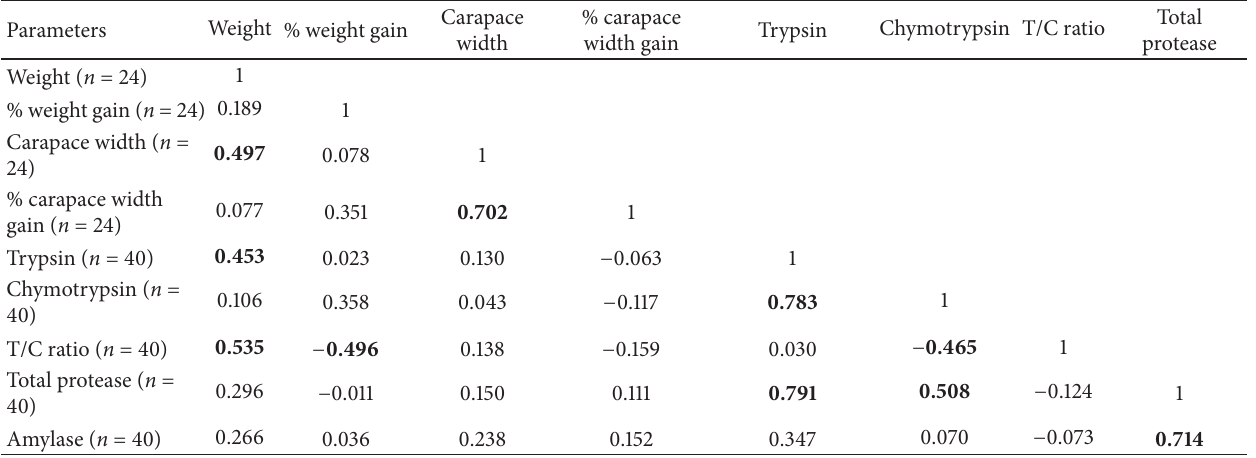
Table 5: Correlation coefficient ( r ) between different parameters studied during a molting period of adult P. pelagicus . Significant correlations are indicated in big bold numbers ( P <